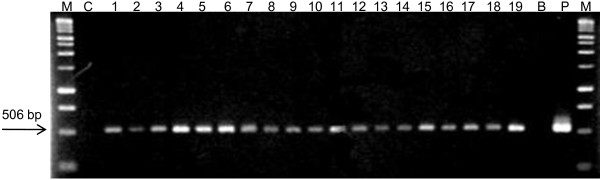
PCR detection of the HPTII hygromycin resistance gene in transgenic coffee plants. The plants were produced from 7-month-old embryogenic callus cultures co-cultivated with A. tumefaciens strain LBA1119 carrying out the pMDC32 binary vector. M - Molecular weight DNA markers (1 kb), C - untransformed coffee plant (control), 1-19 transgenic coffee plants derived from independent transformation events, B - blank, PCR mix without DNA, P - plasmid. The arrow indicates the fragment corresponding to the HPTII gene (506 bp).